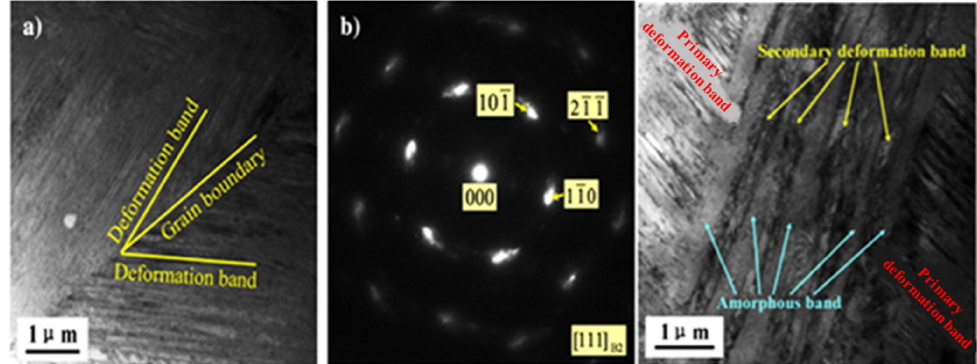
Figure 12. The nanocrystallization and amorphization mechanism for the TiNi sample under local canning compression in which the deformation bands of the TiNi sample were subjected to 50% plastic deformation, where ( a ) bright-field TEM image showing the deformation bands next to the grain boundary and ( b ) SAED pattern showing B 2 austenite structure, adapted with permission from [56], 2022, Elsevier.